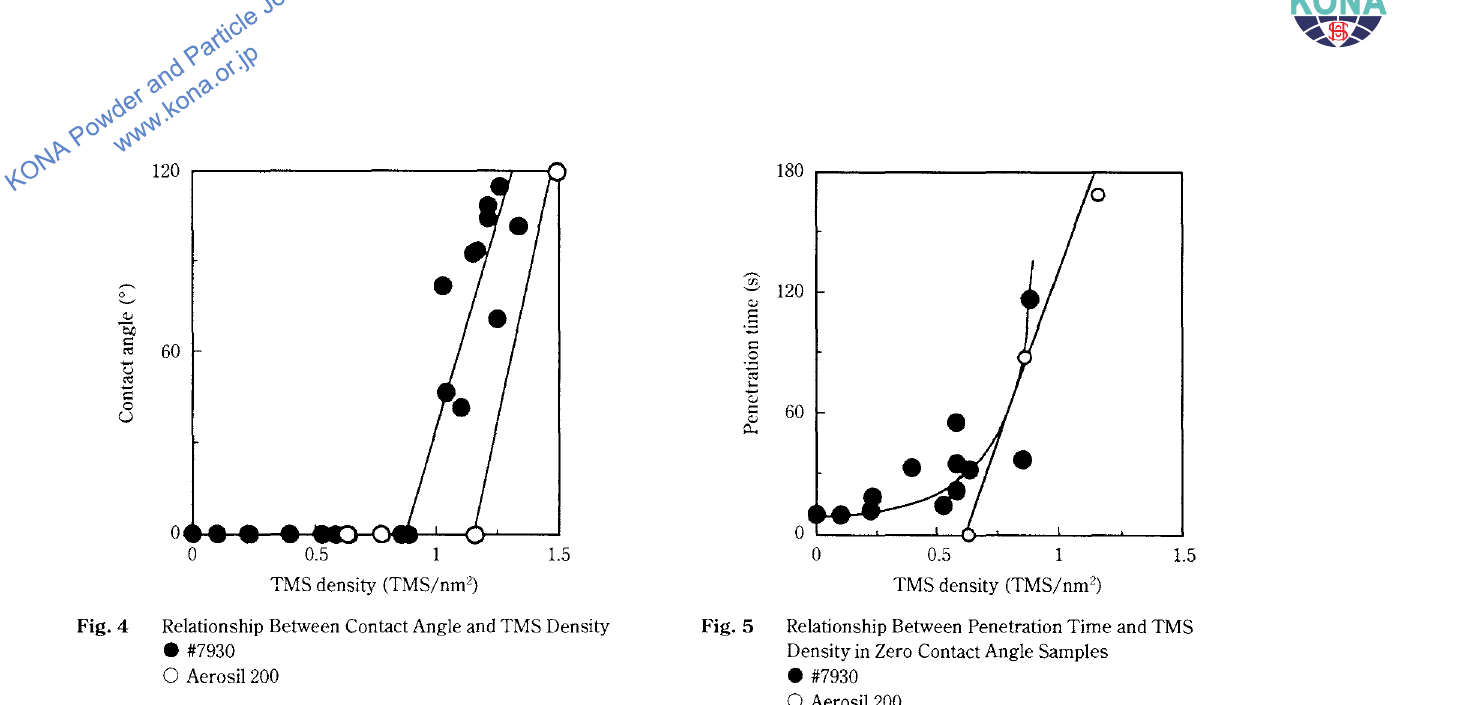
Relationship Between Contact Angle and TMS Density Relationship Between Penetration Time and TMS Density in Zero Contact Angle